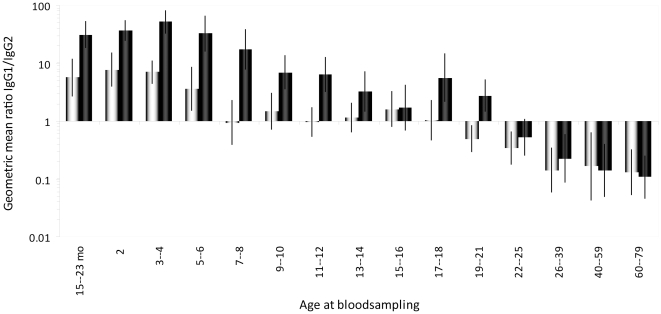
Meningococcal serogroup A and C PS-specific IgG1/IgG2 ratios (grey and black bars, respectively).An IgG1/IgG2 ratio of >1 indicates a higher level of IgG1; an IgG1/IgG2 ratio of <1 indicates a higher level of IgG2. MenCC immunization is offered at 14 months of age and children and adolescents between 5–21 years of age received a single immunization 4–5 years earlier. Error bars indicate 95% confidence intervals. Age at bloodsampling is indicated in years or as stated otherwise (mo  =  age in months).